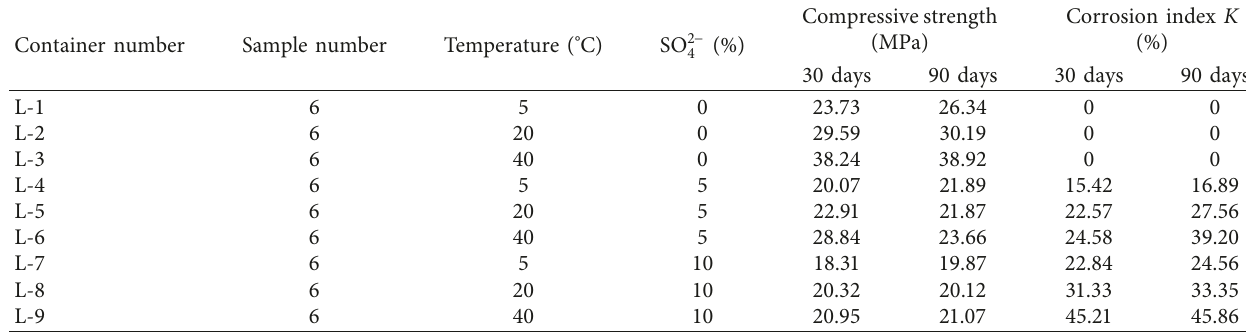
Table 3: The compressive strengths of corrosion concrete with various temperatures.